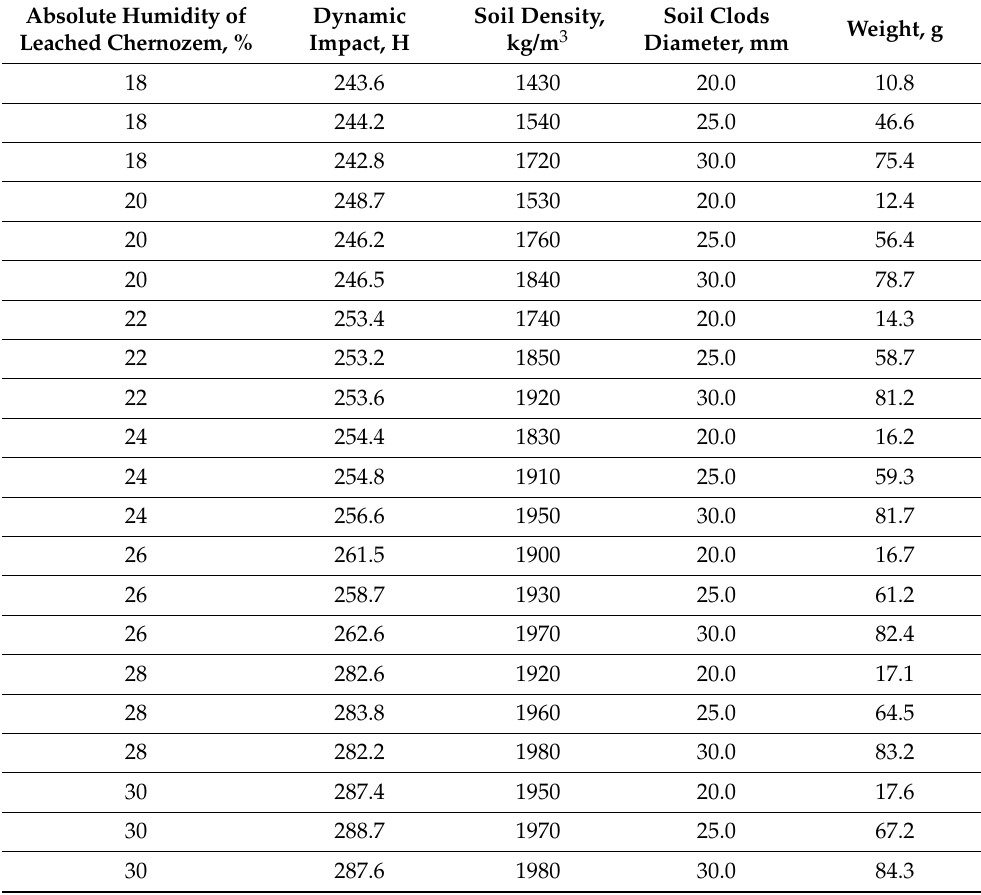
Table 1. The results of studies on the dynamic destruction of soil clods.